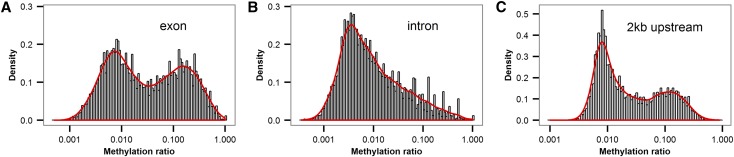
The distribution of the methylation ratios per genomic function. Distribution of methylation in (A) exons, (B) introns, and (C) 2 kb from the transcriptional start site.